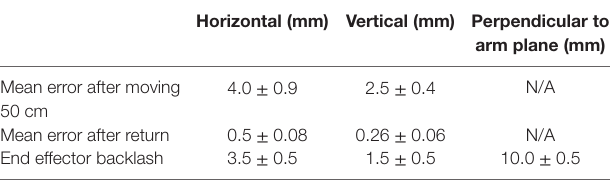
TaBle 1 | The results of the validation